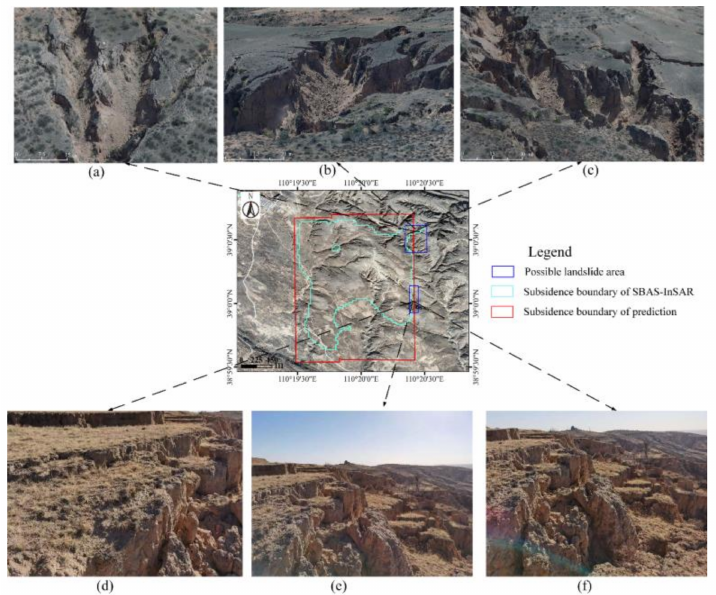
Figure 13. Field investigation of landslide: ( a – c ) Landslide of the O area. ( d – f ) Another landslide